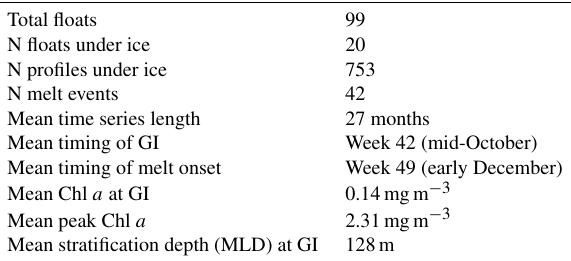
Table 2. Summary of properties of the under-ice BGC-Argo data set. Note: GI – growth